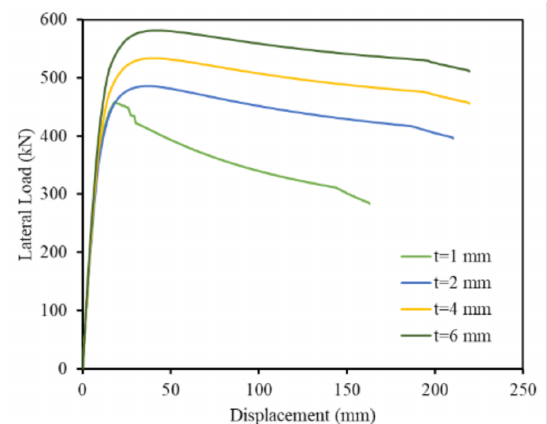
Figure 19. Lateral load-displacement curves according to the inner tube thickness (S-S cross-section).